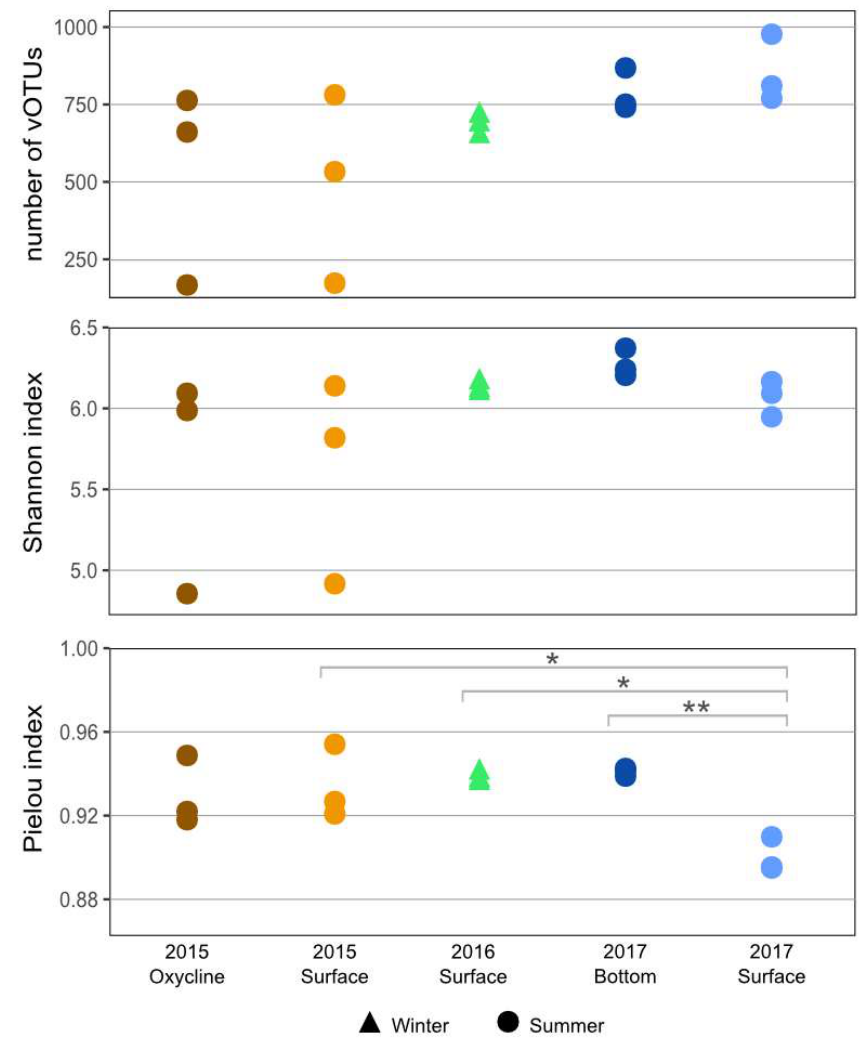
Figure 2. Viral sample richness in summer and winter surface samples from SAS2A lake. Diversity results are shown based on the number of viral taxa present (upper panel), the Shannon diversity index (middle panel) and the Pielou’s index (lower panel). Significant differences are indicated with * for p ≤ 0.05 and ** for p ≤ 0.01.